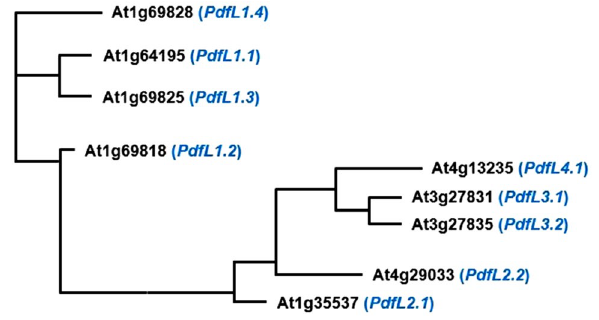
Figure 3. Phylogenetic tree of all 9 PDFL peptides. Alignment of the mature peptides was done with CLUSTAL Omega (http:// www. ebi. ac. uk/ Tools/ clust alw/ index. html). Tree was calculated at http:// iqtree. cibiv. univie. ac. at.